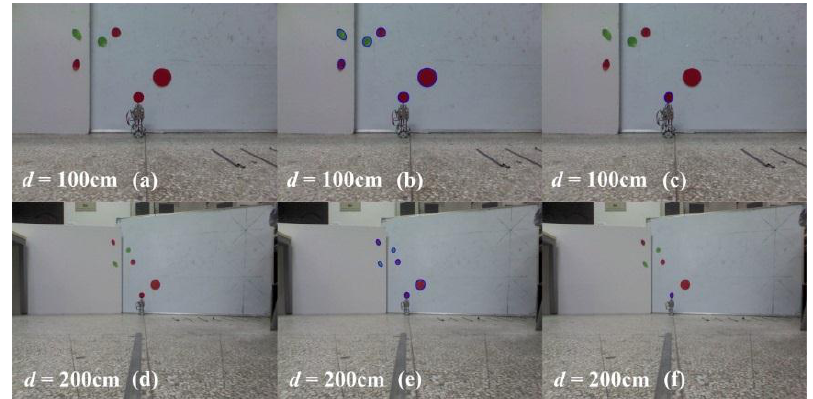
Figure 18. Test results of the carrier detecting the JSN when there are similar shaped and same colored interferences in the surrounding of the label. ( a , d ) are the images before detection; ( b , e ) are the images when all the red and green circles and ellipses are detected; ( c , f ) are the images after the label rotates a proper angle and the JSN is distinguished from the interferences.